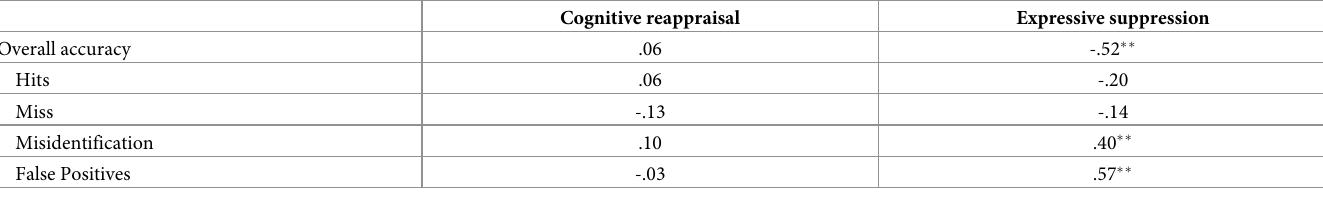
Table 2. Correlations between face immediate face memory and ERQ